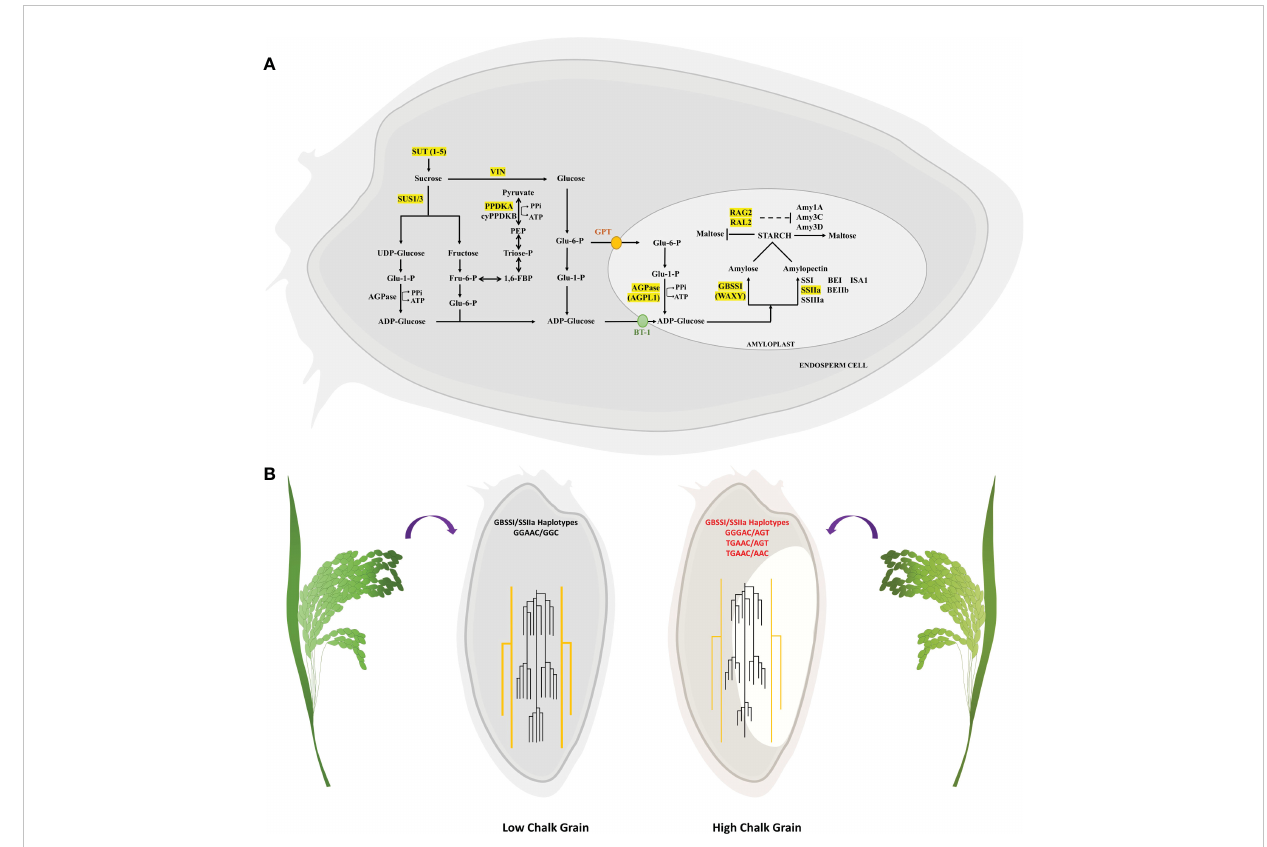
FIGURE 9 Depiction of identi fi ed candidate genes in the starch metabolism pathway and their haplotypic combinations affecting grain chalkiness. (A) Starch metabolism pathway in seeds begins with the sucrose transporters (SUTs) that translocate sucrose into the seeds, followed by its breakdown into glucose and fructose by the enzymatic action of invertases (VIN) and sucrose synthases (SUS). Finally glucose-1-phosphate (Glu-6-P) is converted to ADP-glucose by ADP-glucose pyrophosphorylase(AGPase), which is converted to starch by the combined action of Granule Bound Starch Synthase I (GBSSI) which forms amylose and Starch Synthase IIa (SSIIa) which forms linear glucan chains leading to formation of amylopectin. During HT amylases (Amy) breakdown starch to malto-oligosaccharides. RAG2/RAL2 from alpha-amylase inhibitor family are thought to suppress the amylase activity. (B) Grains with low chalk have high amylose and longer chain length while high chalk grains have low amylose and short chain amylopectin. Low grain chalk seeds have superior haplotypic combination of GBSSI and SSIIa when compared with high chalk